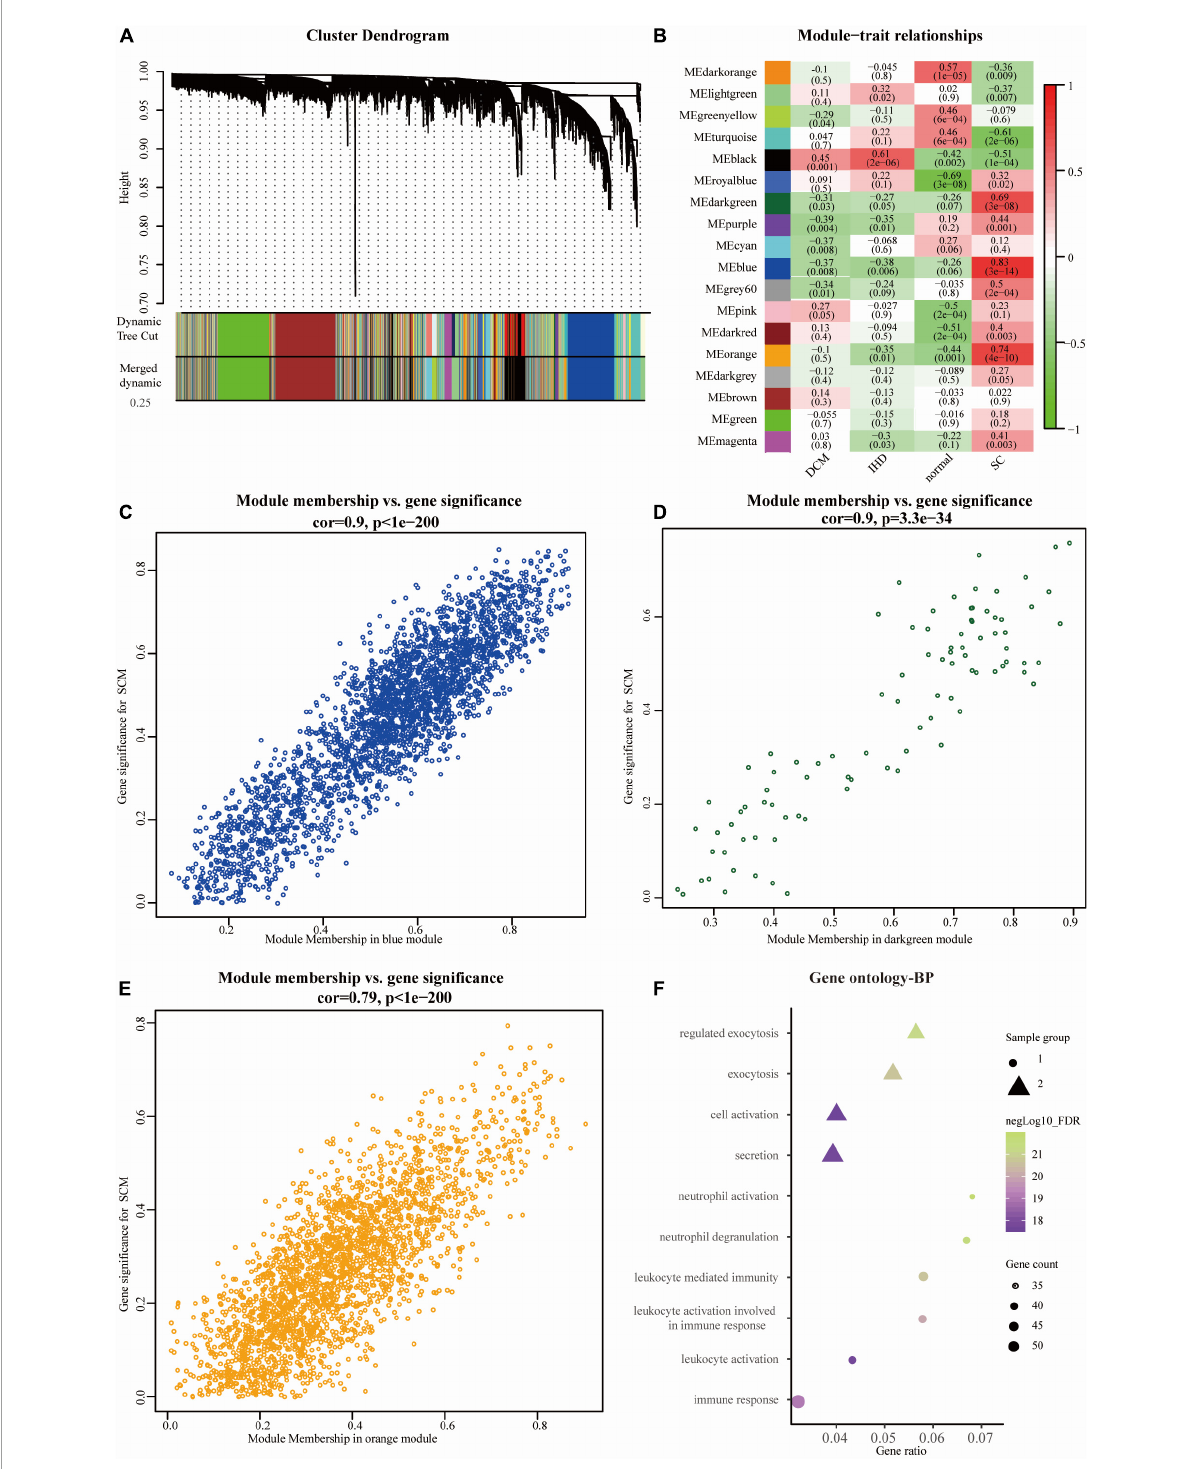
FIGURE2 Overview of WGCNA network construction of all genes (A) Gene modules’ dendrogram plots of all genes; (B) module-trait relationships of four groups in 18 modules. (C–E) Module membership vs. gene significance between three significant modules, including blue module (Pearson cor = 0.9, p < 1e-200), dark green module (cor = 0.9, p = 3.3e-34), and orange module (Pearson cor = 0.79, p < 1e-200); (F) the bubble diagram showing the GO (biological process, BP) function enrichment of genes in sub-modules. The size represents the gene counts, and node colors show the gene expression negative Log10_FDR (false discovery